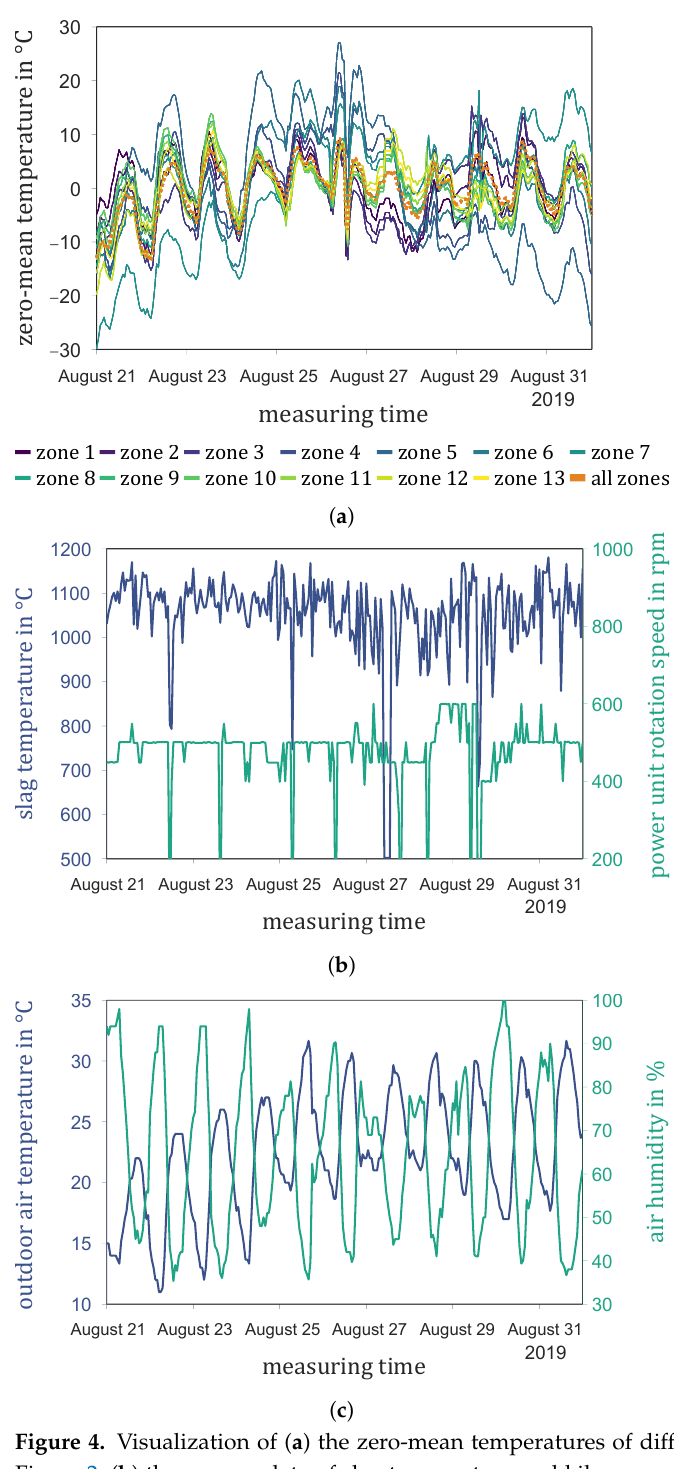
Figure 4. Visualization of ( a ) the zero-mean temperatures of different kiln-shell zones shown in Figure 2; ( b ) the process data of slag temperature and kiln power unit rotation speed; and ( c ) the weather data containing the outdoor air temperature and air humidity. The representation of the temperatures from all zones in Figure 4a illustrates the similarity of the temperature profiles. Differences only occur in the middle temperature zones (zones 4–6), since higher temperatures and less accretions are to be expected in these areas due to the process. Figure 4c shows the outdoor air temperature and the air humidity for the considered time period. Both variables show a wave-like course, with the maxima shifted by half a